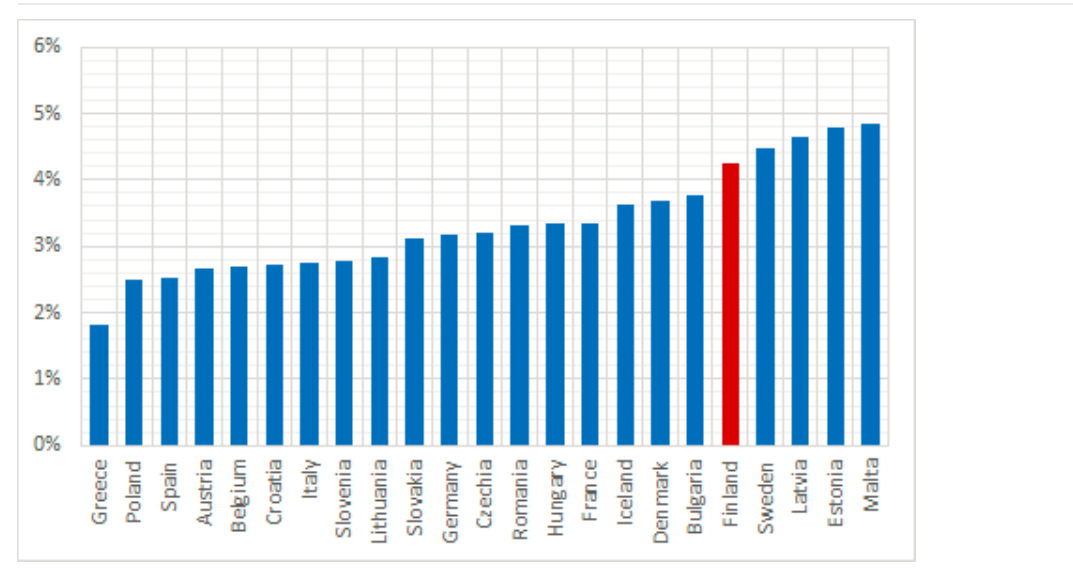
FIGURE 2: ICT employment share of total employment (2020) (EUROSTAT, 2021a). Values for Spain and Malta are for 2019.